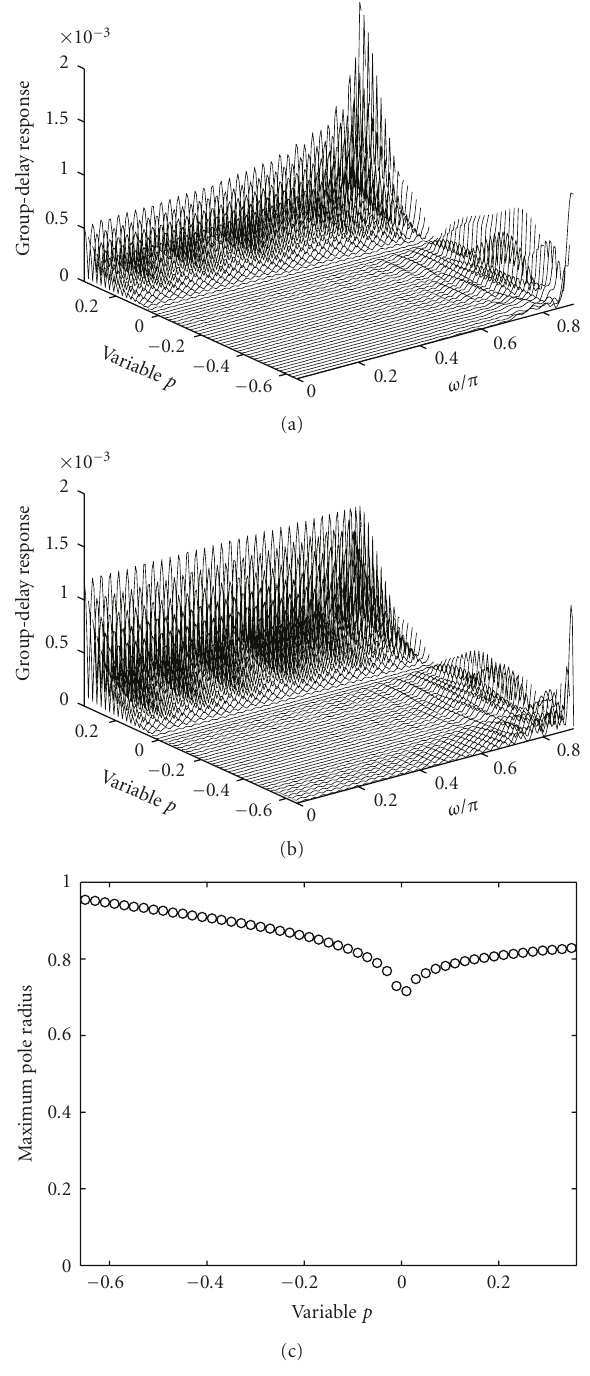
Figure 4: Design of an N = 35, M = 5, ω p = 0 . 9 π , p ∈ [ − 0 . 65,0 . 35] allpass VFD filter. (a) Absolute group-delay errors of the proposed LS design. (b) Absolute group-delay errors of the proposed minimax design. (c) Maximum pole radius for p ∈ [ − 0 . 65,0 .